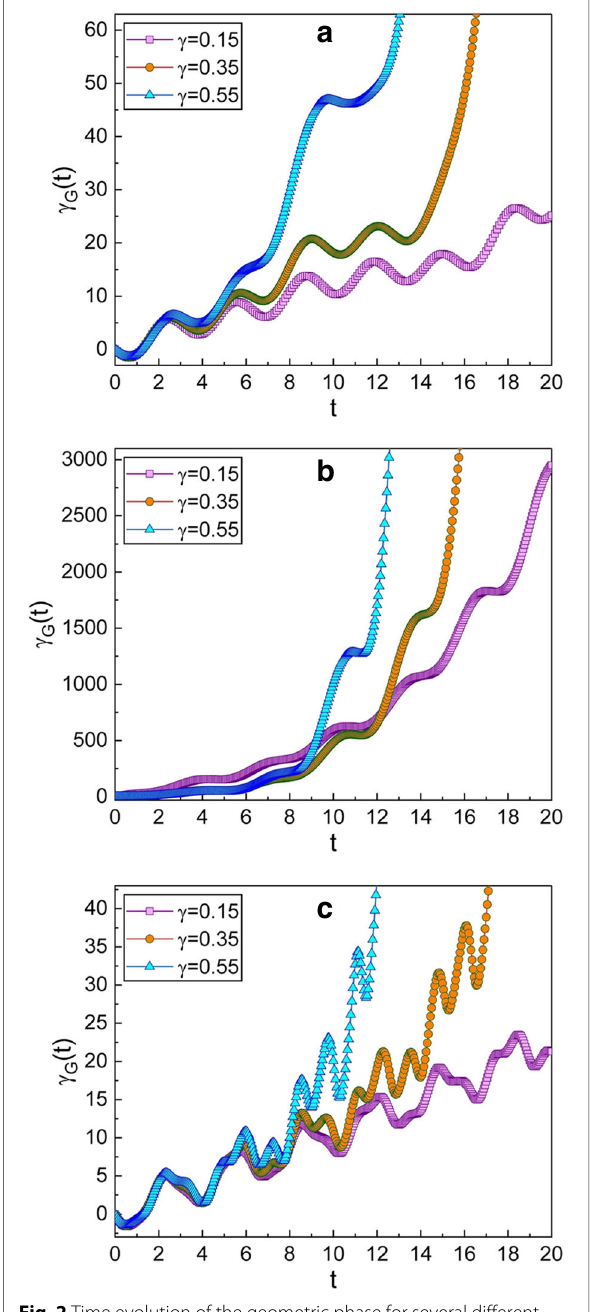
Fig. 1 Time evolution of the geometric phase for several different Fig. 2 Time evolution of the geometric phase for several different values of A 0 . The values of ( μ , ν ) used in the graphics are (1, 0) for a , √ √ √ values of γ . The value of ω used in the graphics is 0.3 for a , 0.99 for b , √ 2, 1) for b , and ( 3, 2) for c . We have used m = 1, ω 0 = 1, ω = 5, ( 2 and and 5 for c . The squeezing parameters chosen here are μ = γ = 0.35, f = 1, (cid:2) = 1, ϕ = 0, and γ ( 0 ) = 0. The phase and all ν = 1; this choice gives q -squeezed state at initial time. Other G d parameters are taken to be dimensionless for convenience, and this quantities that we have used are m = 1, ω 0 = 1, A 0 = 1, f d = 1, convention will also be applied to the subsequent figures. Because A 0 ( 0 ) = 0. We confirm that the geometric phase is (cid:2) = 1, ϕ = 0, and γ G is given in terms of the classical amplitude X c ,0 of the complementary large when the damping factor γ is large in most cases, but not all. function [see Eq. (12)], we can confirm from the graphics that the The frequency of the case b is near to the resonant frequency, geometric phase is large when the oscillation amplitude is high. We whereas those of a and c are far from the resonant one. The geometric also see that the fluctuation of γ G ( t ) becomes large as the values μ phase for the resonant case ( b ) increases very rapidly over and ν increase under the condition given in Eq. (14)